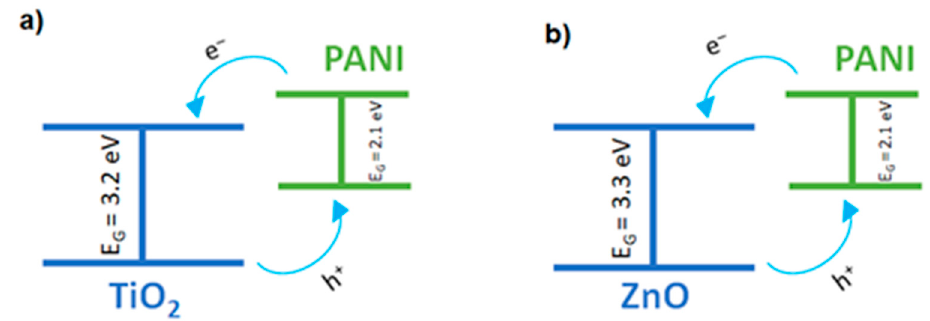
Figure 5. Schematic energy diagram for the composite of ( a ) PANI/TiO 2 and ( b )